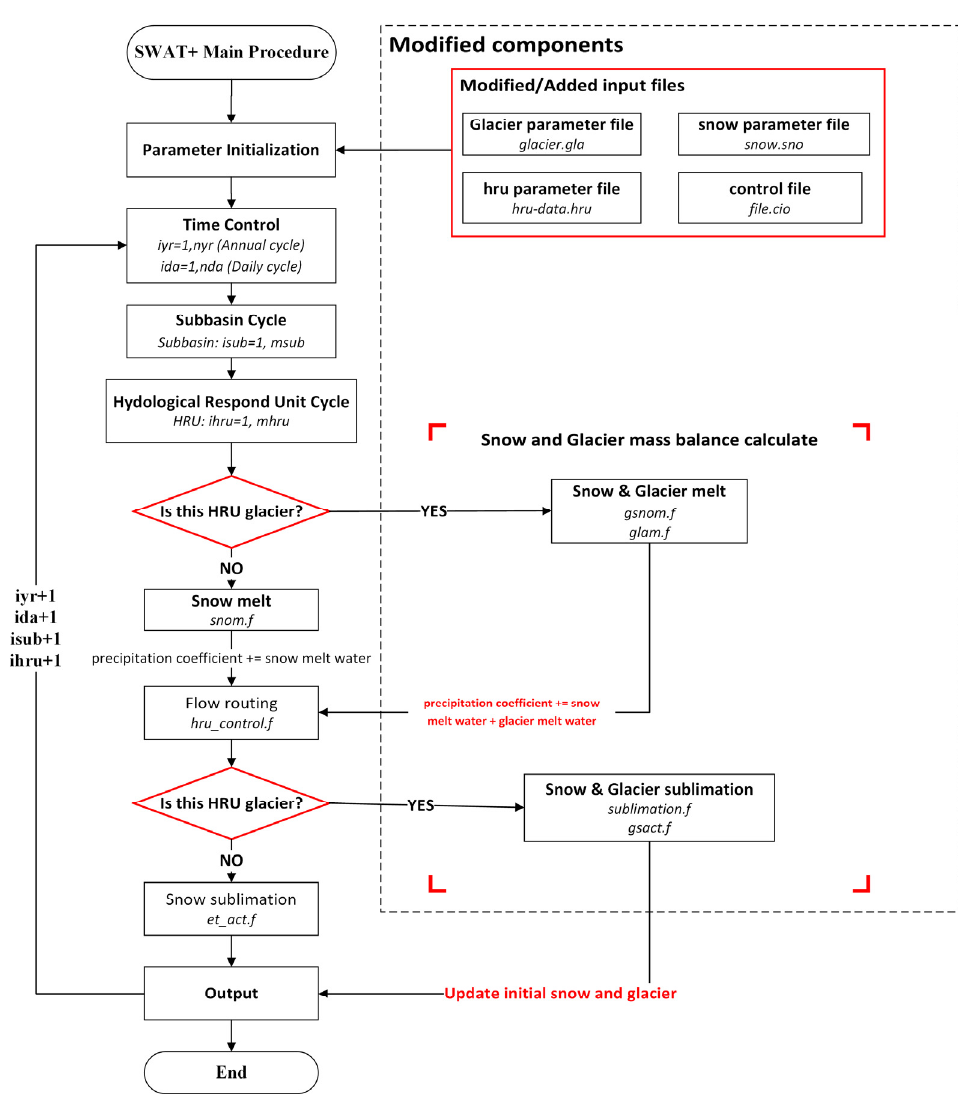
Figure 1. Framework of incorporating glacier hydrological process into SWAT+, where iyr stands for the number of the years (nyr in total); ida presents the number of the days (nda in total); isub is the subbasin number (msub in total); ihru is the hru number (mhru in total).